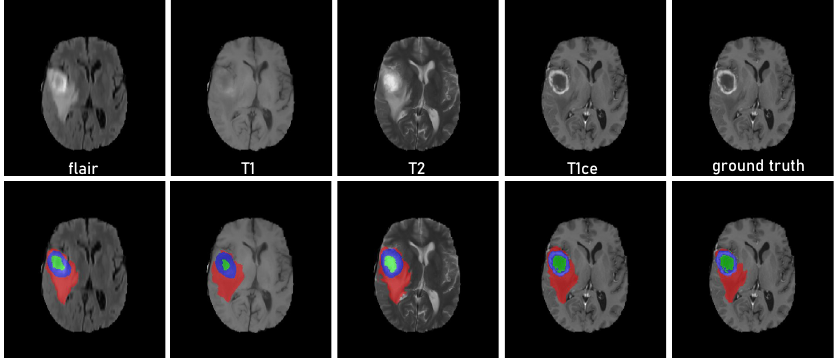
Figure 4. Qualitative results of the framework obtained on the brain tumor dataset [5] using uni- modality as input. The green indicates NCR/NET regions, blue indicates ET regions, and red indicates ED regions.